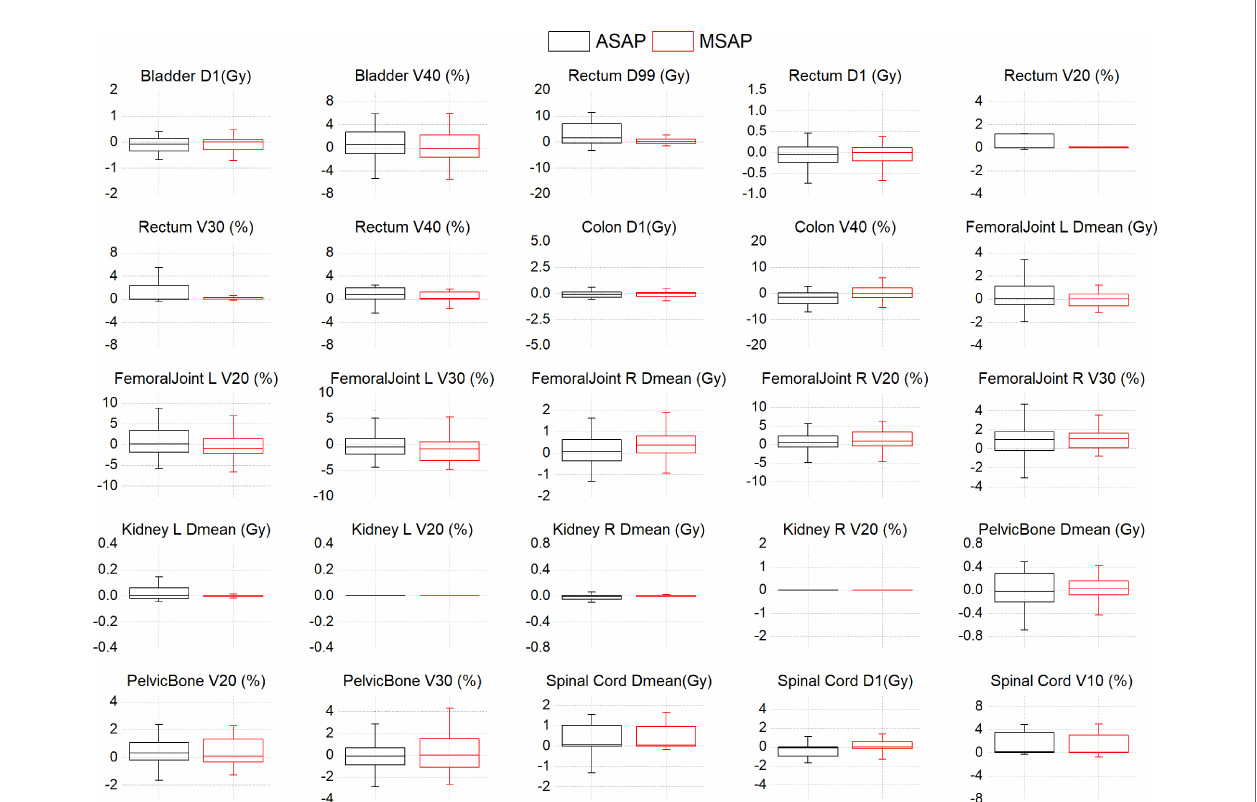
FIGURE 3 | The dose differences of DVH parameters between the AS-VMAT plans and the MS-VMAT plans of 22 patients.The black box represents the ASAP vs. MSMP results, and the red box represents the MSAP vs. MSMP results. ASAP, Automatic Segmentation in AS-VMAT Plan; MSAP, Manual Segmentation in AS- VMAT Plan; MSMP, Manual Segmentation in MS-VMAT